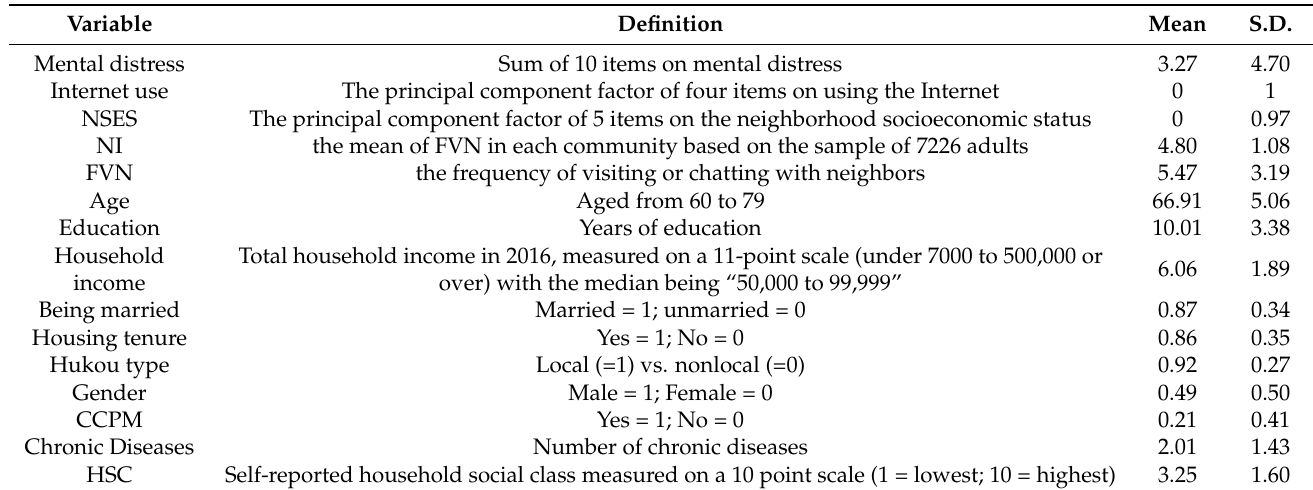
Table 1. Definition of key variables and descriptive analysis ( n =